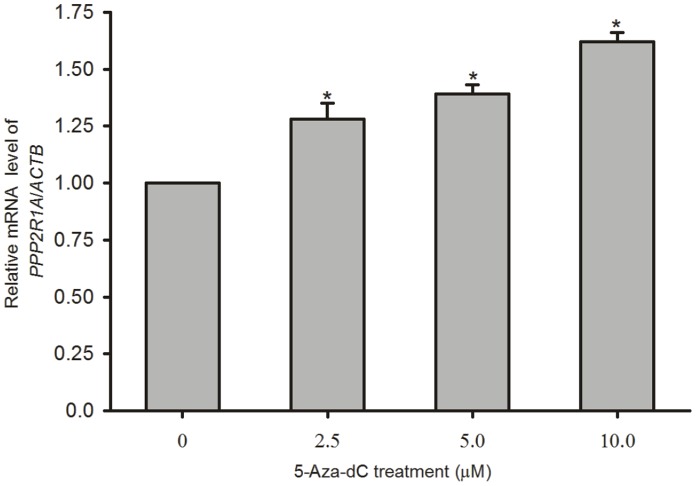
Treatment with 5-Aza-dC upregulates the transcription of PPP2R1A in L02 cells.RNA was extracted from immortalized human normal hepatocyte L02 cells treated with or without 5-Aza-2′-deoxycytidine (5-Aza-dC), a DNA methylation inhibitor, for 48 hours at the indicated concentrations (2.5, 5.0 and 10.0 µM), and the PPP2R1A transcripts in the control group and the 5-Aza-dC treated group were quantified using real-time RT-PCR (normalized against ACTB). The results were normalized against the untreated control (Ctrl), which was given a value of as 1.0. Compared with the Ctrl, the levels of PPP2R1A mRNA in the 5-Aza-dC treated groups were increased by statistically significant levels (∗ P<0.05). The level of PPP2R1A mRNA in the 10.0 µM 5-Aza-dC treatment group was significantly higher than the mRNA level in the 2.5 µM 5-Aza-dC treatment group (#
P<0.05). The results represent the mean ± SD of at least three independent experiments performed in duplicate.